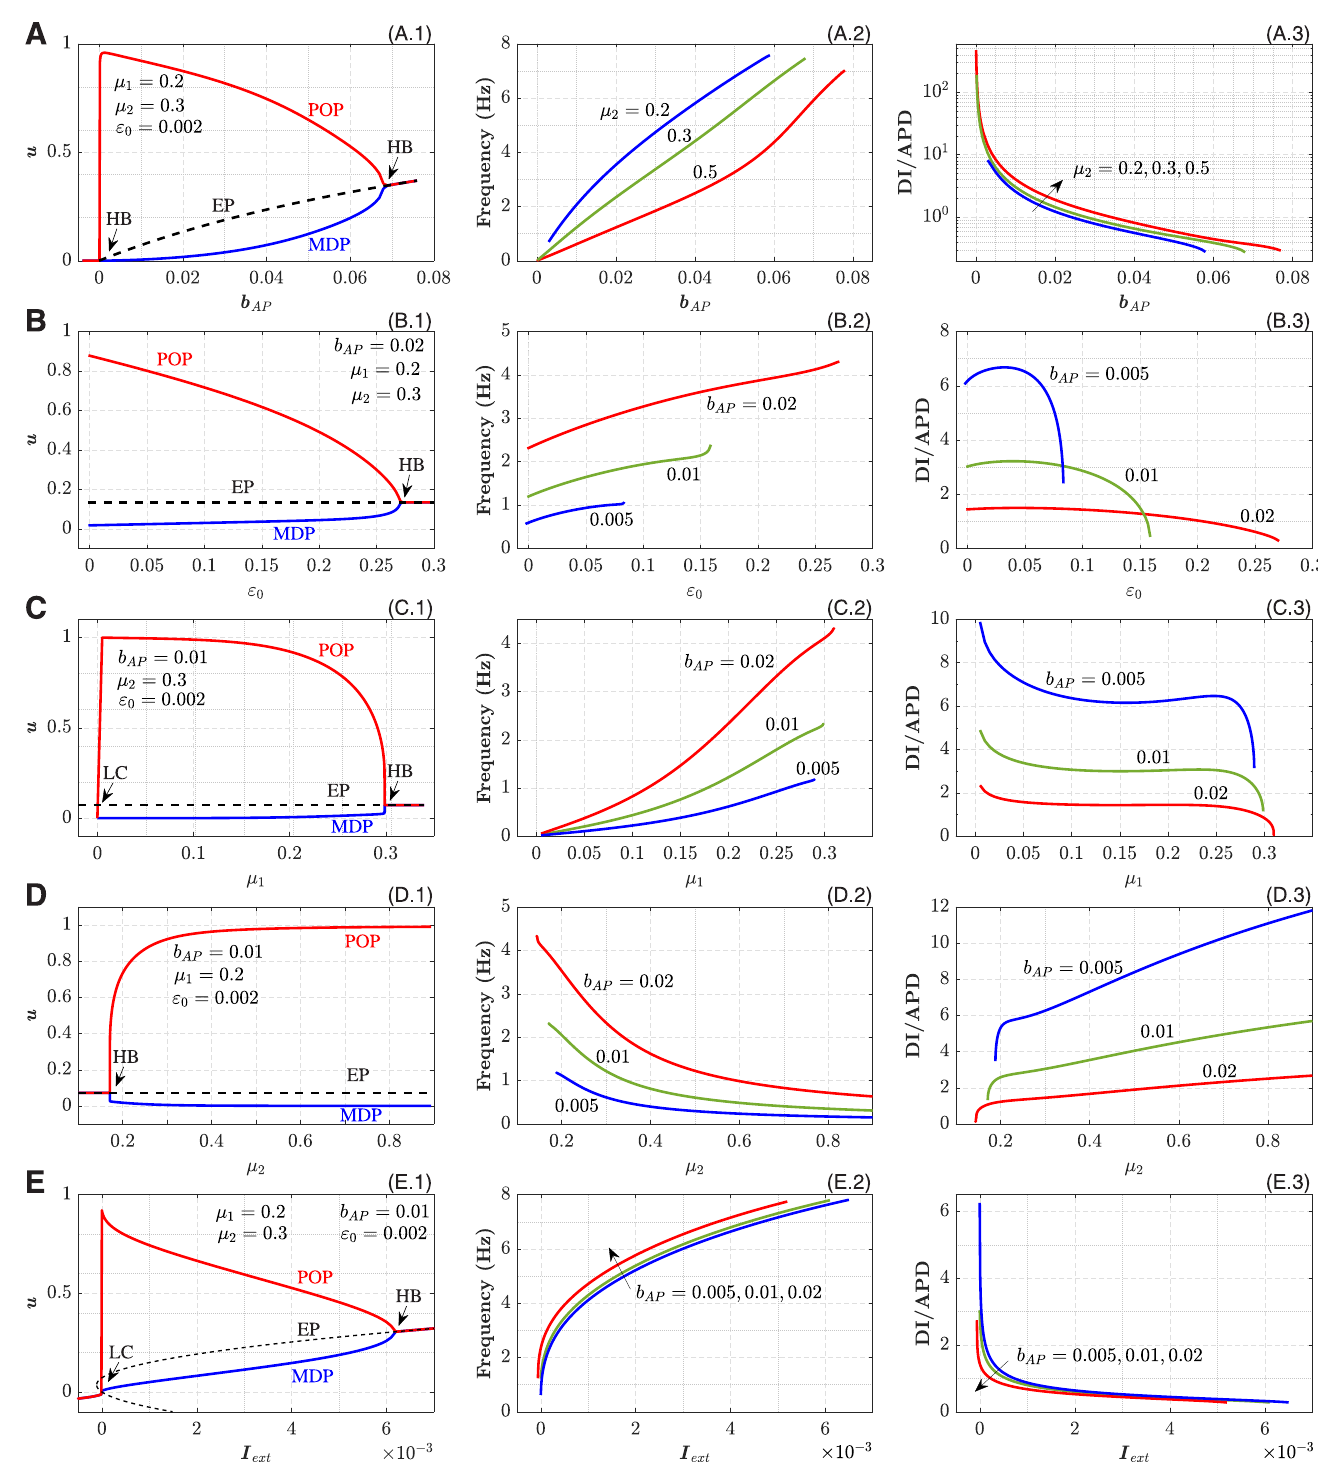
Fig 4. Dependence of pAP cell characteristics on various parameters. A. On the bifurcation parameter b AP . B. On the parameter � 0 . C. On the parameter μ 1 . D. On the parameter μ 2 . E. On the external current I ext . Left panels correspond to the bifurcation diagrams, central—to the calculated frequencies, and right panels—to the calculated DI on APD ratios.